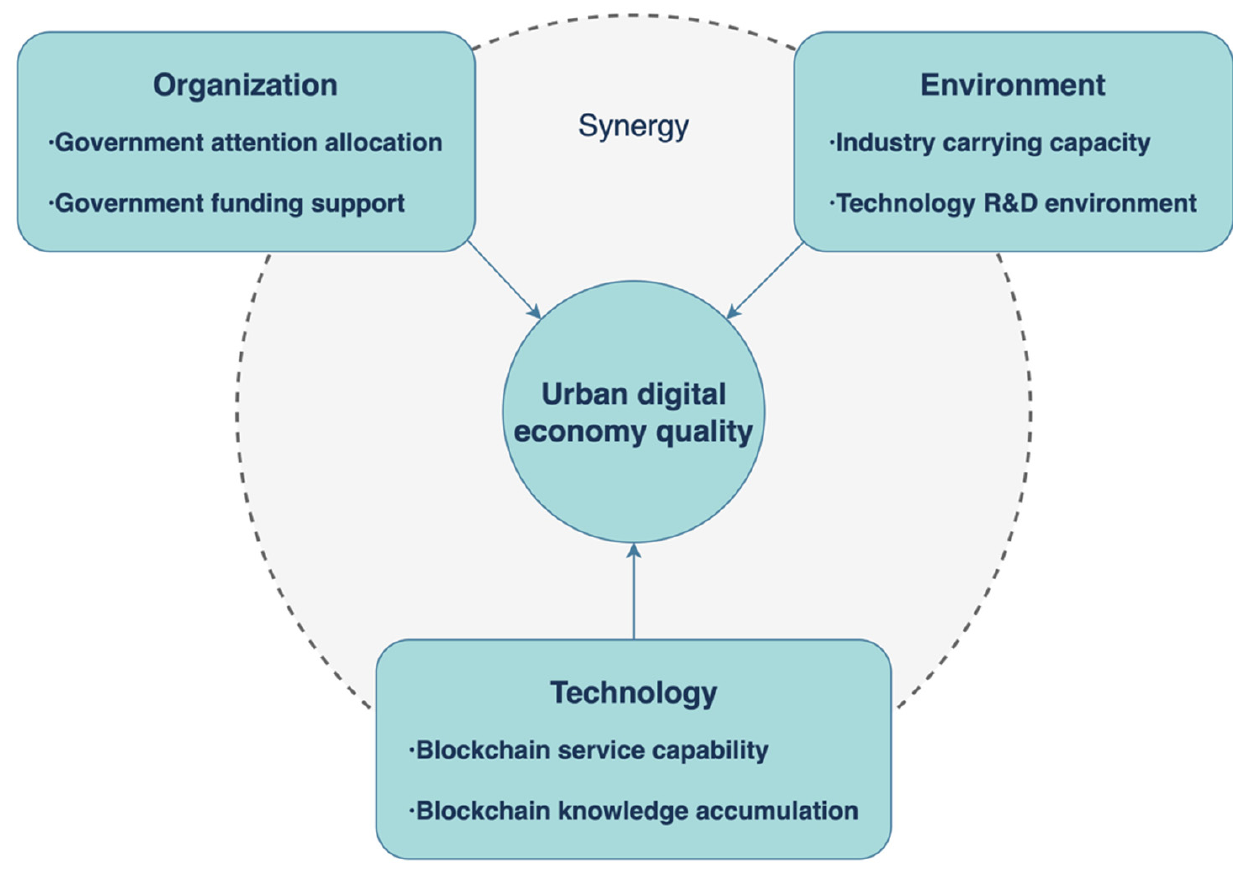
Figure 1. Configurational model of the quality-driven mechanism of the urban digital economy based on TOE framework.